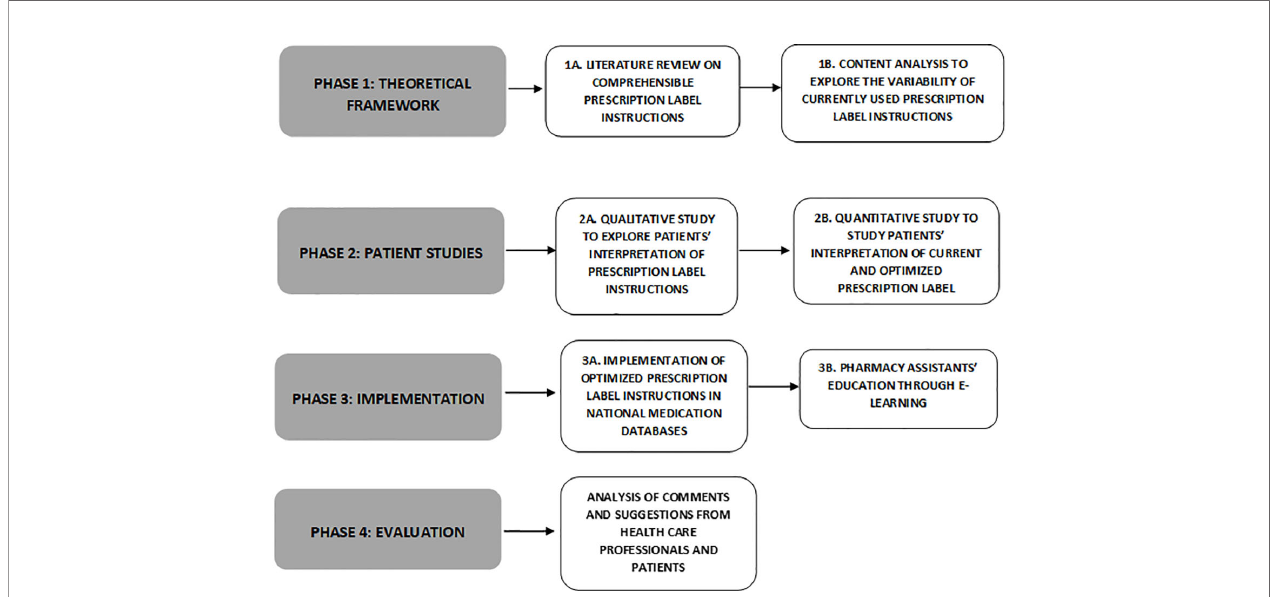
FIGURE 1 | Flow chart of the four phases research on the study, development, implementation, and evaluation of comprehensible prescription label